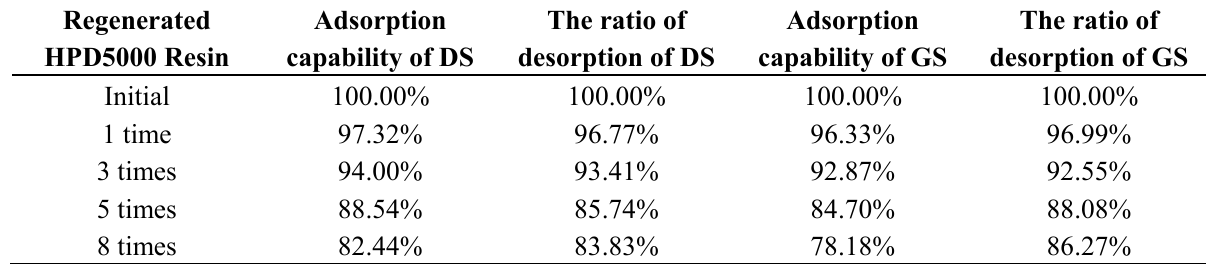
Table 3. Adsorption and desorption capacity of regenerated HPD5000